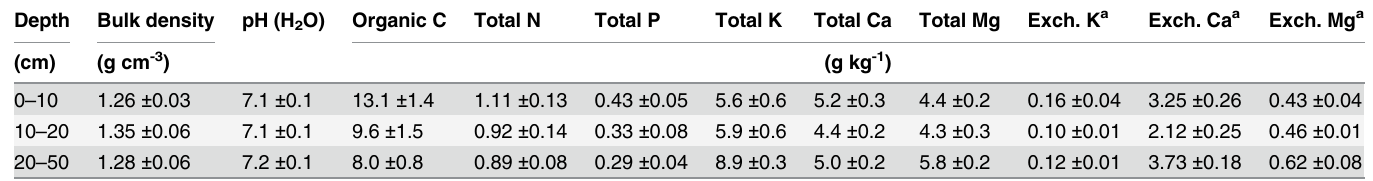
Table 1. Properties of soil at the study site: a P . deltoides plantation at the Zhoushan Forestry Farm, Jiangsu, China. Depth Bulk density